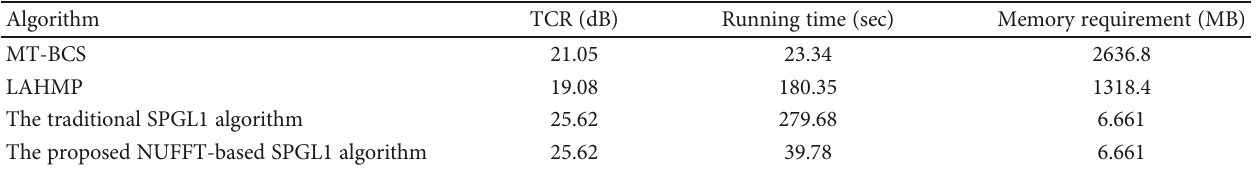
Table 1: Comparison of four